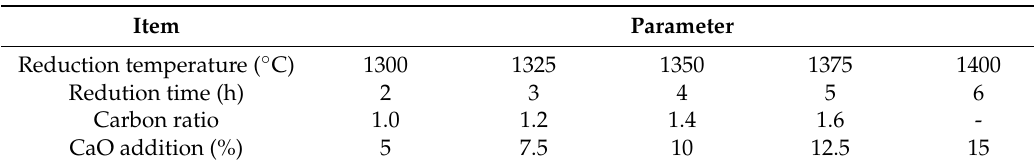
Figure 3. Schematic diagram of tube furnace system for low-grade saprolitic laterite nickel ore carbon composite hot briquette (LSLN-CCB) reduction. Table 3. Details of the experimental parameters.